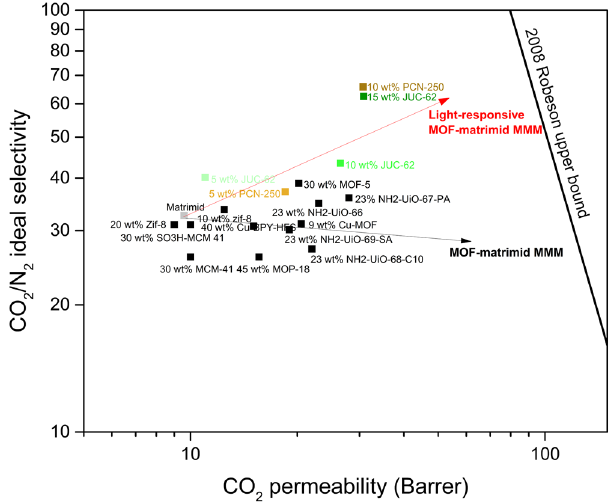
Figure 6. CO 2 /N 2 separation performance of light-responsive MOF-Matrimid mixed matrix